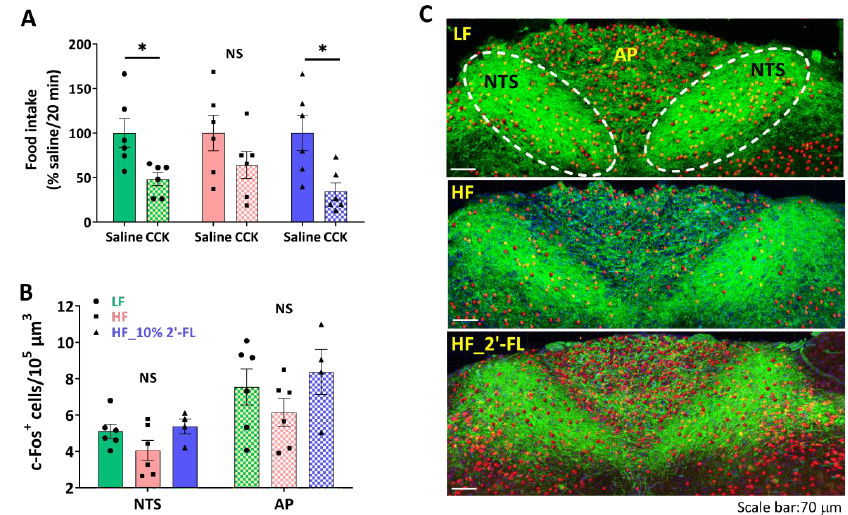
Figure 2. E ff ect of 10% 2 (cid:48) -FL supplementation on vagally-mediated gut-brain signaling. CCK sensitivity ( A ) and c-Fos positive cells in the nucleus of the solitary tract (NTS) and area postrema (AP) in the hindbrain ( B , C ; blue: DAPI, green: ib4, red: c-Fos) in mice fed an LF, HF, or HF_10% 2 (cid:48) -FL diet for six weeks. Paired Student’s t-test was used to determine statistical significance within groups for CCK sensitivity. One-factor ANOVA was performed to analyze c-Fos expression in the NTS and AP areas. Di ff erences between groups were analyzed by using Tukey’s post hoc tests. Values are means ± SEMs, n = 6 / group. * denotes significant di ff erences in food intake between saline and CCK treatment at p < 0.05. NS, not significant. ANOVA, analysis of variance; CCK, cholecystokinin; DAPI, 4 (cid:48) ,6-diamidino-2-phenylindole; HF, high fat; HF_10 % 2 (cid:48) -FL, HF with 10% 2 (cid:48) -FL ( w / v ) in drinking water; IB4, isolectin B4; LF, low fat; 2 (cid:48) -FL,